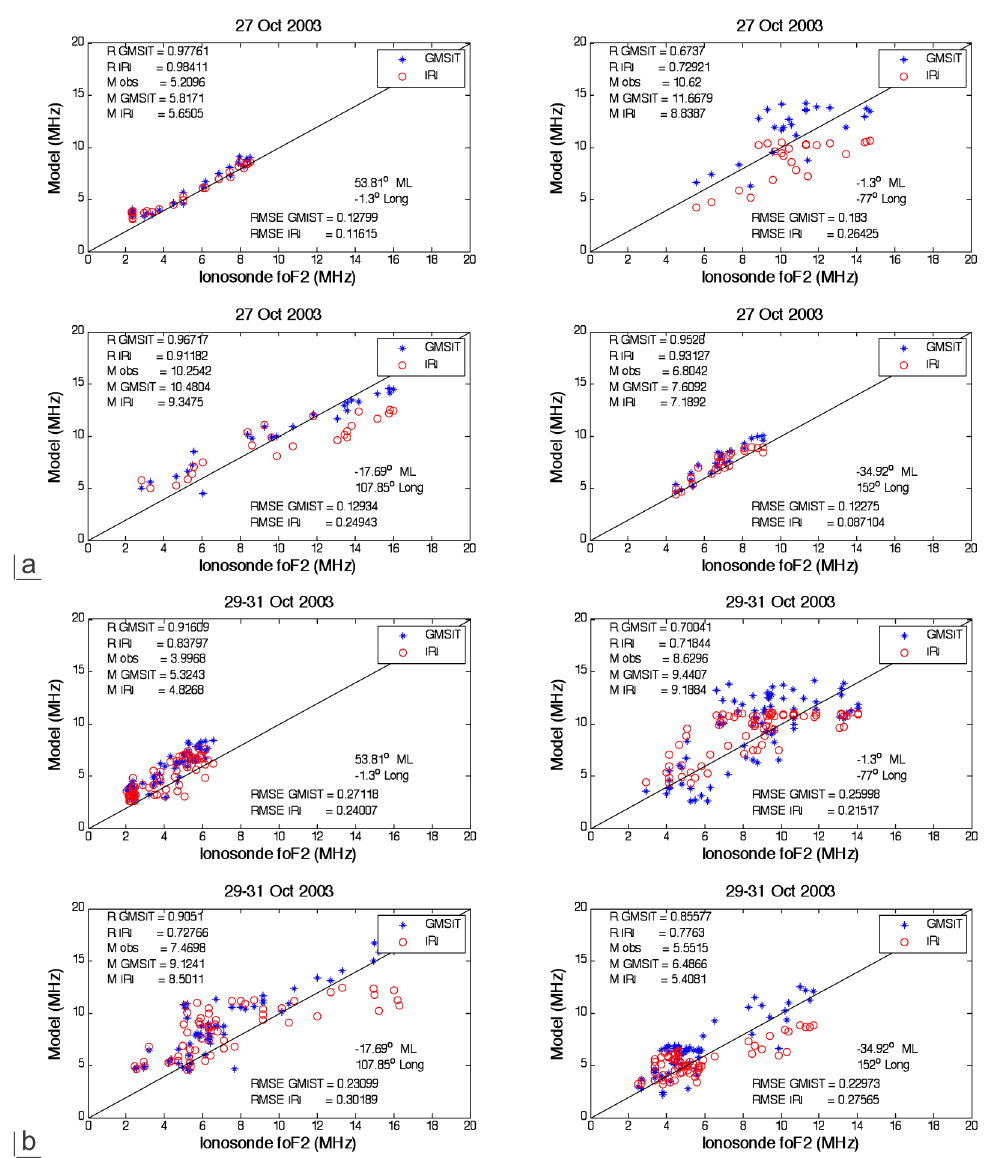
| — Figure 6. Scatter diagram of estimated foF2 by GMIST and IRI STORM from observations at ionospheric stations of different regions of the globe. The geomagnetic latitude and geographic longitude of each station is given at the low-right edge of each plot.